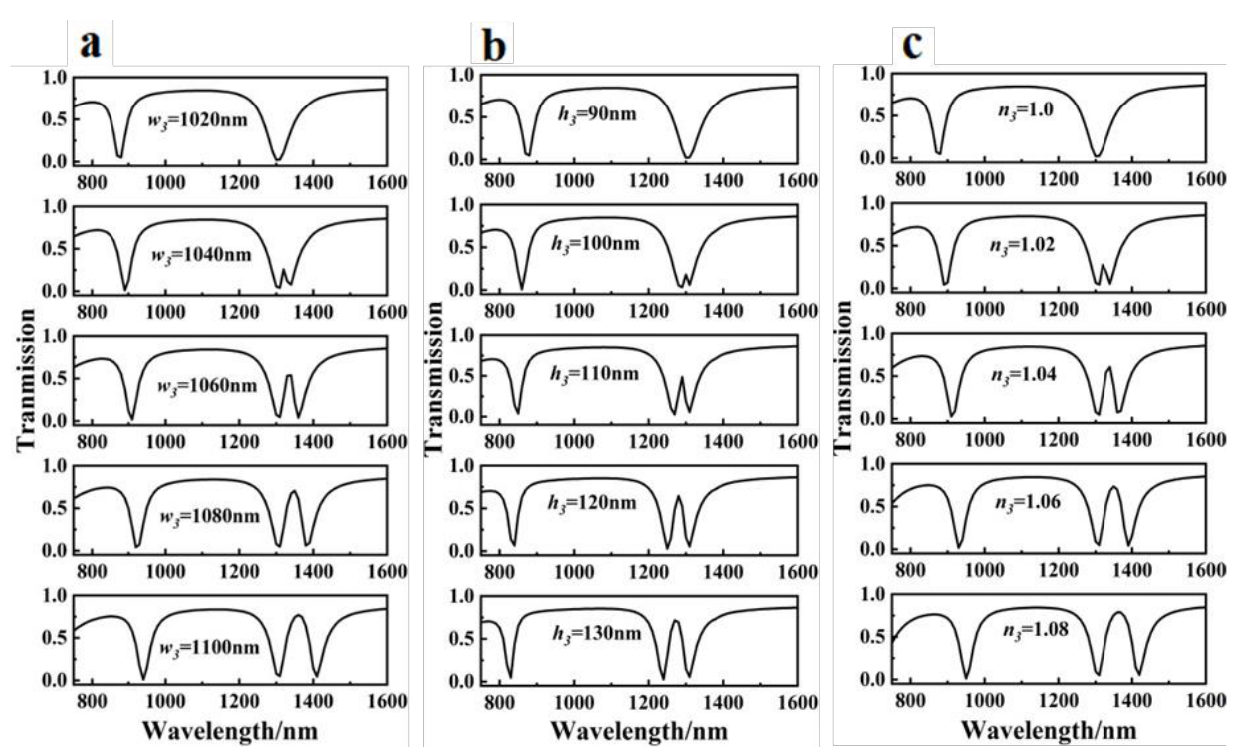
Figure 4. Off-to-on transmission spectra of three-rectangle-resonator PIT system with different ( a ) w 3 , ( b ) h 3 , and ( c ) n 3 .